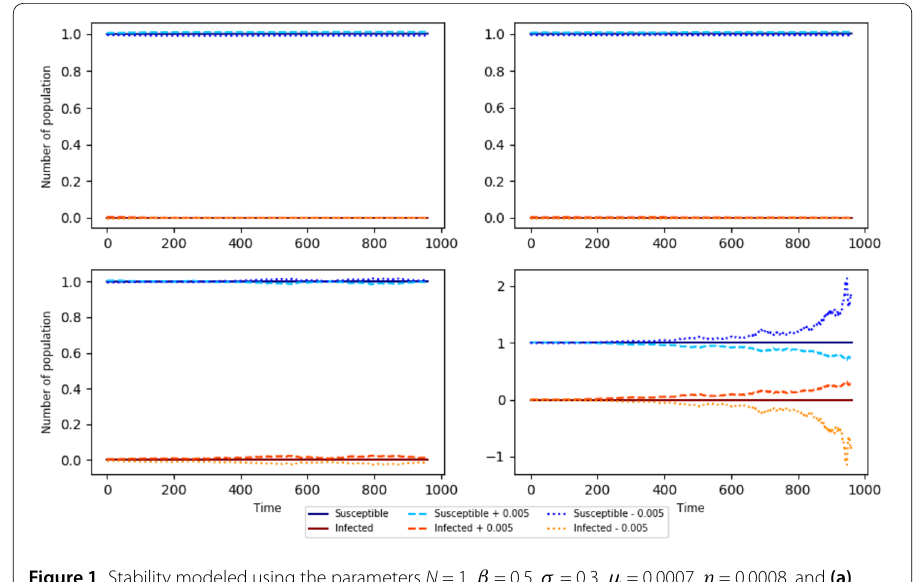
η 2 σ 2 N 2 – μ (lower left) and ( d ) γ = 0.2 (lower μ – 2 μ 2